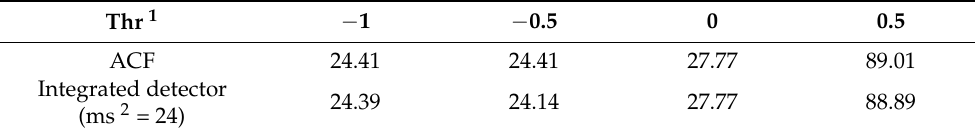
Table 11. AMRs (%) of the reasonable subset for the Caltech test set. The ACF detector was pretrained with the Caltech training set.